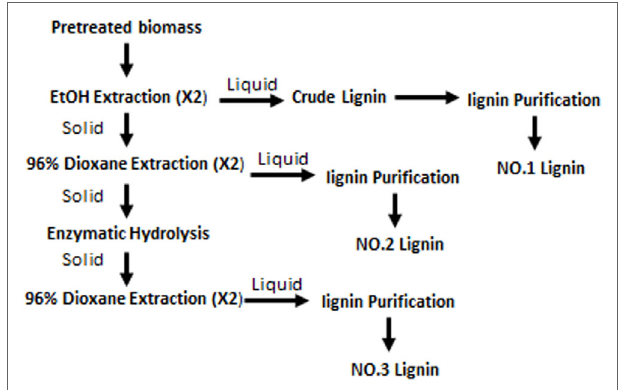
FigUre 1 | Fractionation of lignin from dilute-acid pretreated switchgrass.